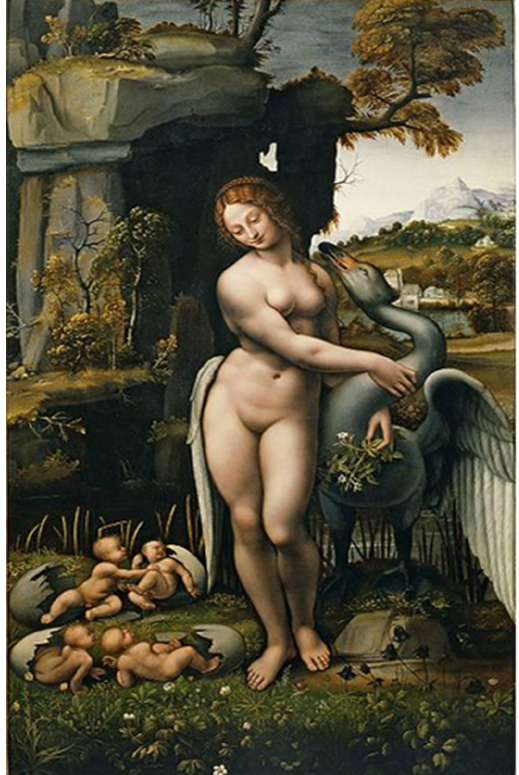
Figure 11. Leonardo da Vinci. “Leda and the Swan” (1515).